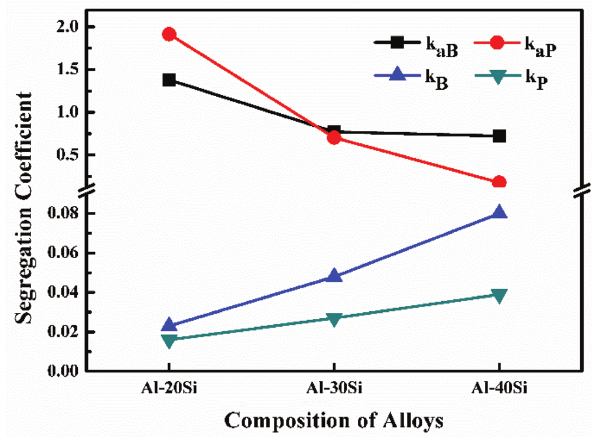
Figure 7: Segregation coefficient of B and